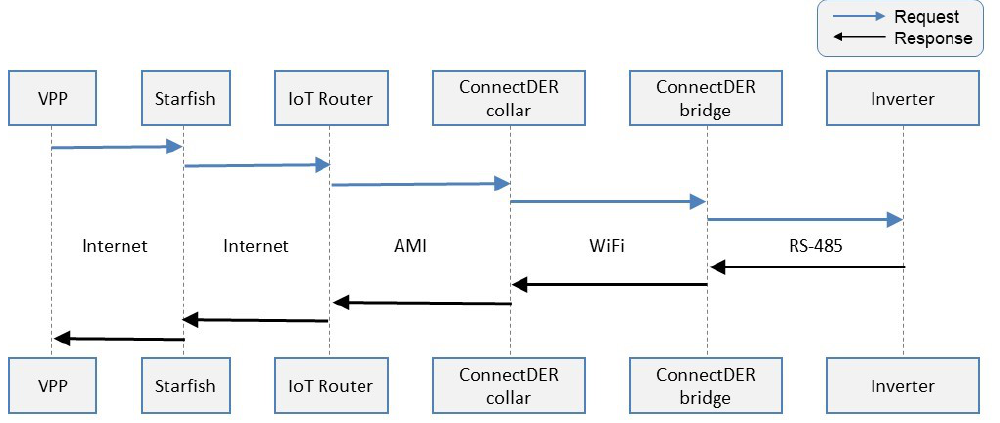
Figure 5. Message flow across the communication link.